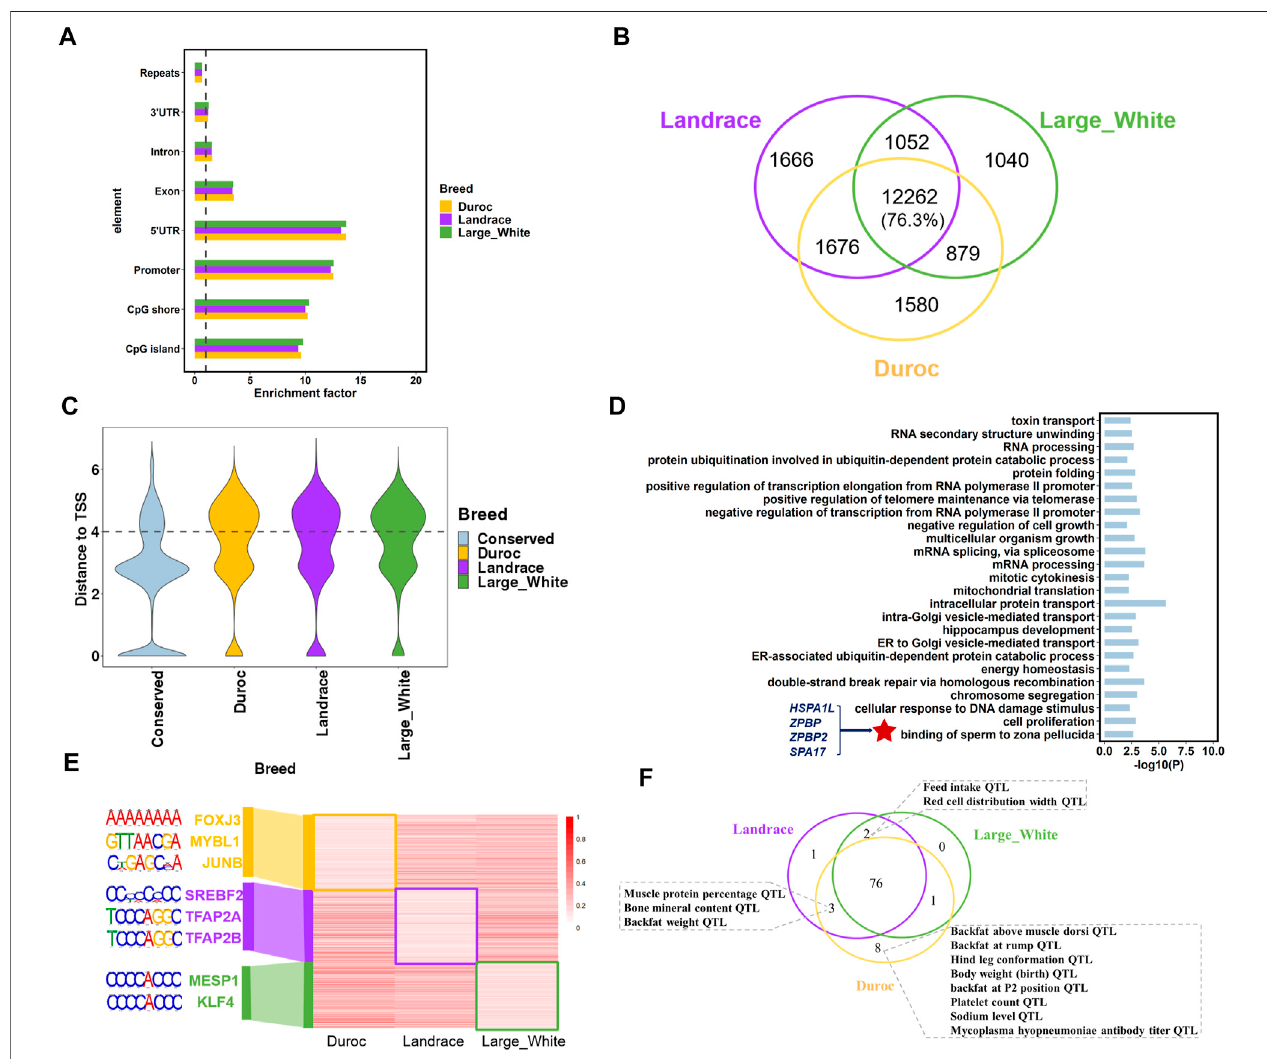
FIGURE3| Porcine sperm hypomethylated regions(HMRs) characteristics. (A) Theenrichmentof HMRsacrossgenomicelements. (B) The number ofconserved HMRs of the three porcine breeds. (C) The distribution of distances from the different types of HMRs to closet TSS. (D) Go term ( p < 0.05) analysis of genes associated withbreeds-conservedhypomethylated( < 20%)promoters(hypo-genes)inpigs. (E) Themethylationlevelandthesigni fi cantDNAmotifsofbreed-speci fi cHMRs. (F) The overlapped pig QTLs and breed-speci fi c HMRs in the three porcine